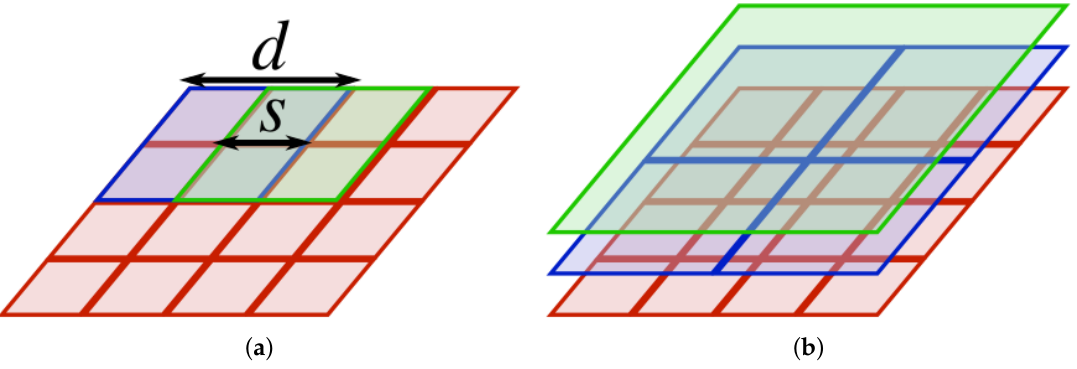
Figure 5. The illustration of how the patches cover the densely sampled image. In ( a ), the coverage on a single scale is shown. The patch dimensions are d × d , and the parameter s determines the offset between the centers of the patches; in ( b ), three final layers in a pyramid of patches covering the image are shown (no overlap between the patches is shown in this example for